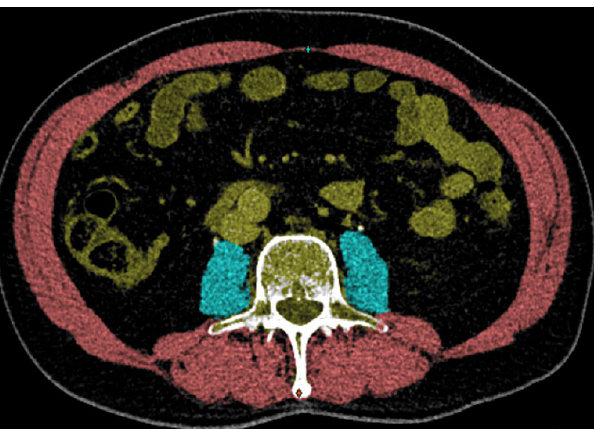
Figure 1 . Cross-sectional CT image in the semi-automatic program SarcoMeas. Illustrating the artificial intelligence stratification of abdominal wall and paraspinal muscles (red), left and right psoas muscles (blue), and abdominal viscera (yellow), based on radiographic density in Hounsfield